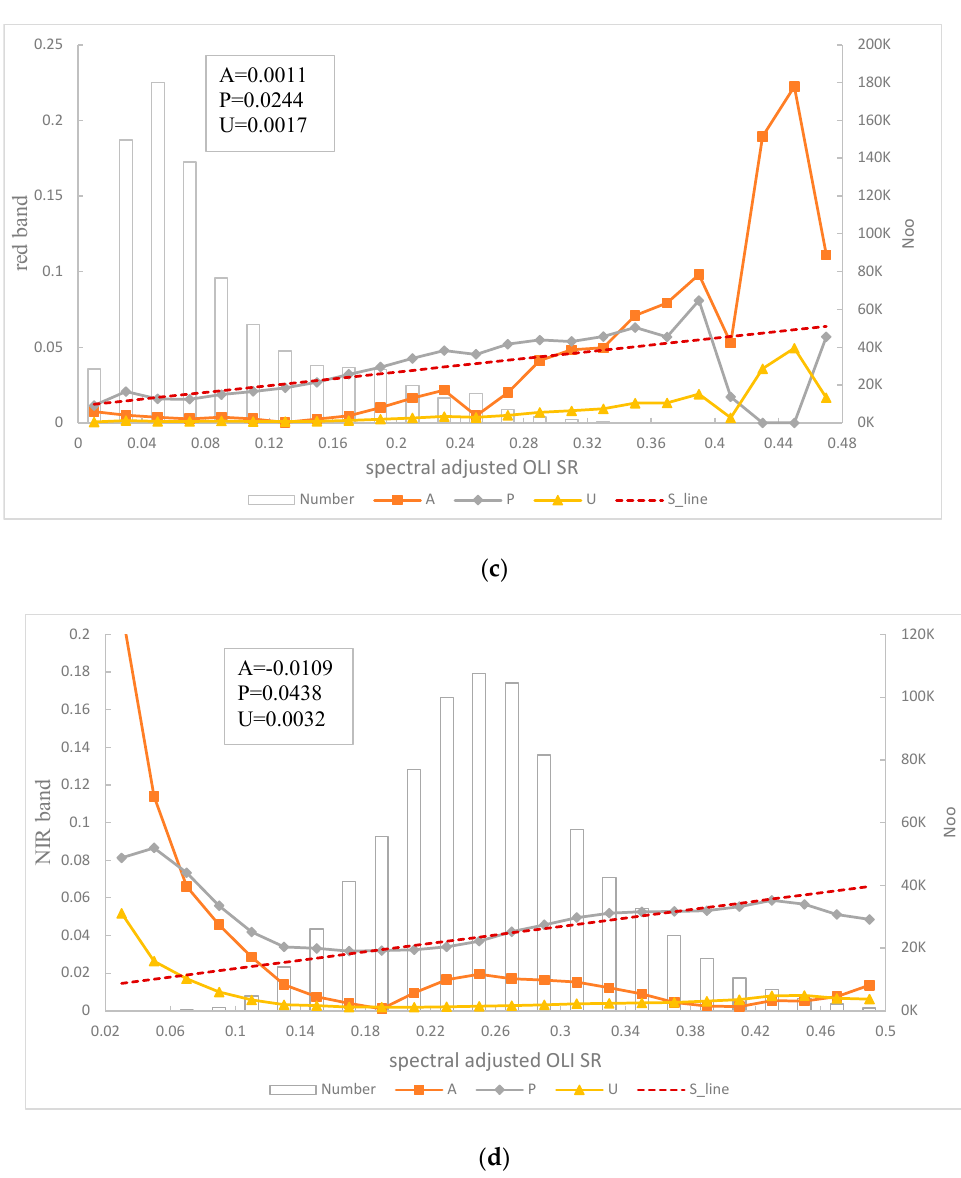
Figure 8. Cross-comparison SR APU graphs. Reported A (accuracy), P (precision), and U (uncertainty) of surface reflectance (SR) were computed from the cross-comparison of GF-2 versus the Landsat-8 OLI, used as reference ( x -axis), showing in subgraphs for the blue ( a ), green ( b ), red ( c ), and NIR ( d ) bands, respectively. A, P, and U were computed per 0.02 bins and overall values (entire range) are written on the top-left. The specification of the cross-comparison (S Lnd x GF-2 = 0.112 ρ + 0.0112) is displayed in dashed line (“S_line”). SR reference values histograms are displayed in gray (right axis) with the corresponding number of occurrence (Noo), i.e., the number of considered pixels in each bin.